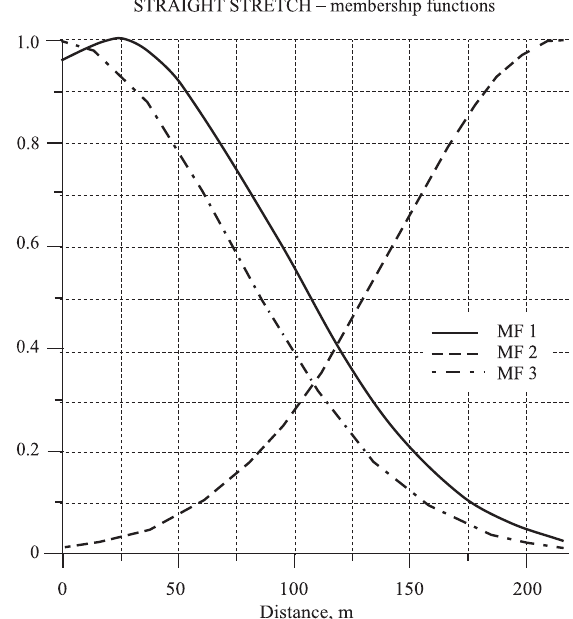
Fig. 7. Membership functions of the input variable Straight Stretch